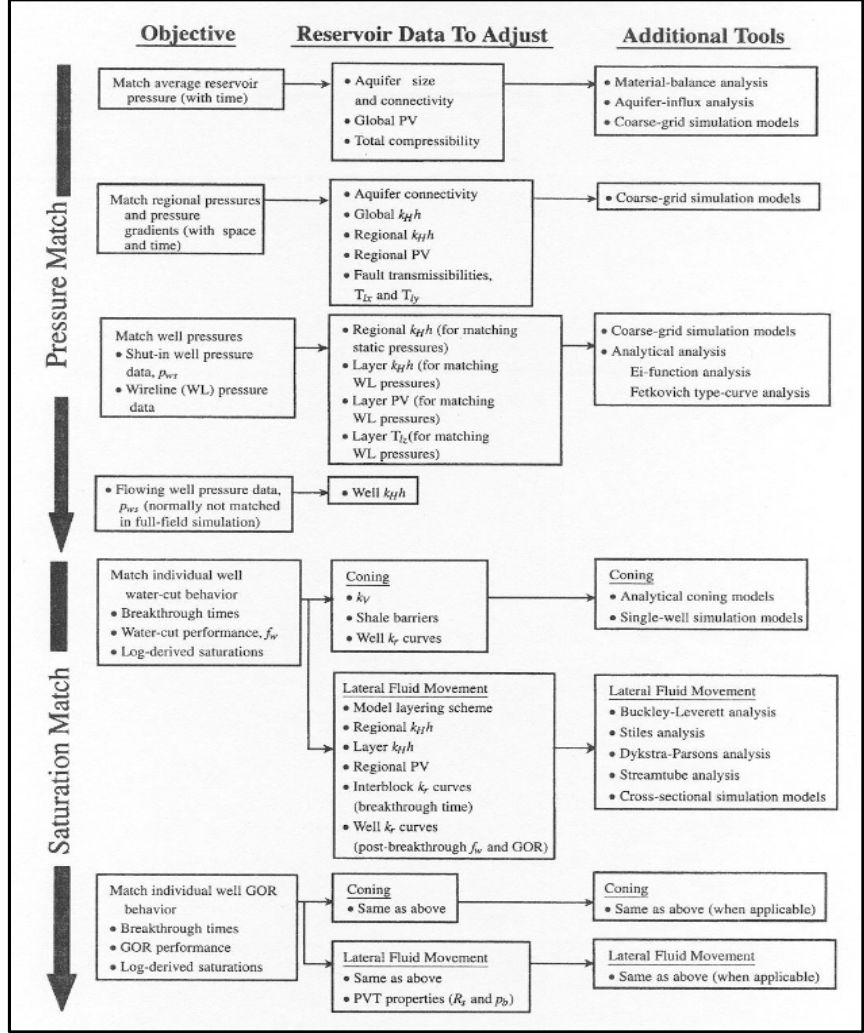
Figure 4. General history matching strategy [16].